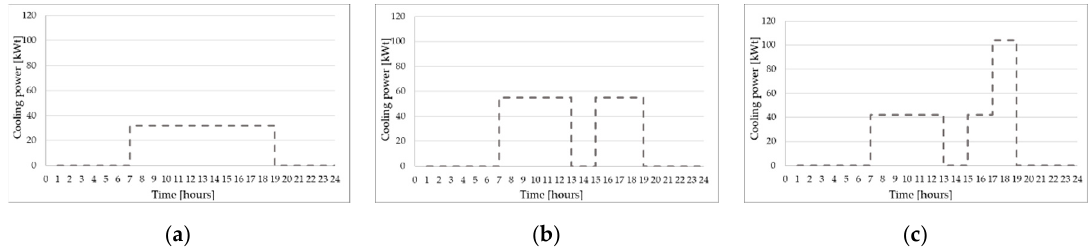
Figure 2. Daily cooling power recovery from a L–CNG fuel station. ( a ): constant profile for a station working every day of the year (P1); ( b ): constant profile for a station not working during weekends and stopping during lunch time (P2); ( c ): variable profile for a station not working during weekends and stopping during lunch time (P3).